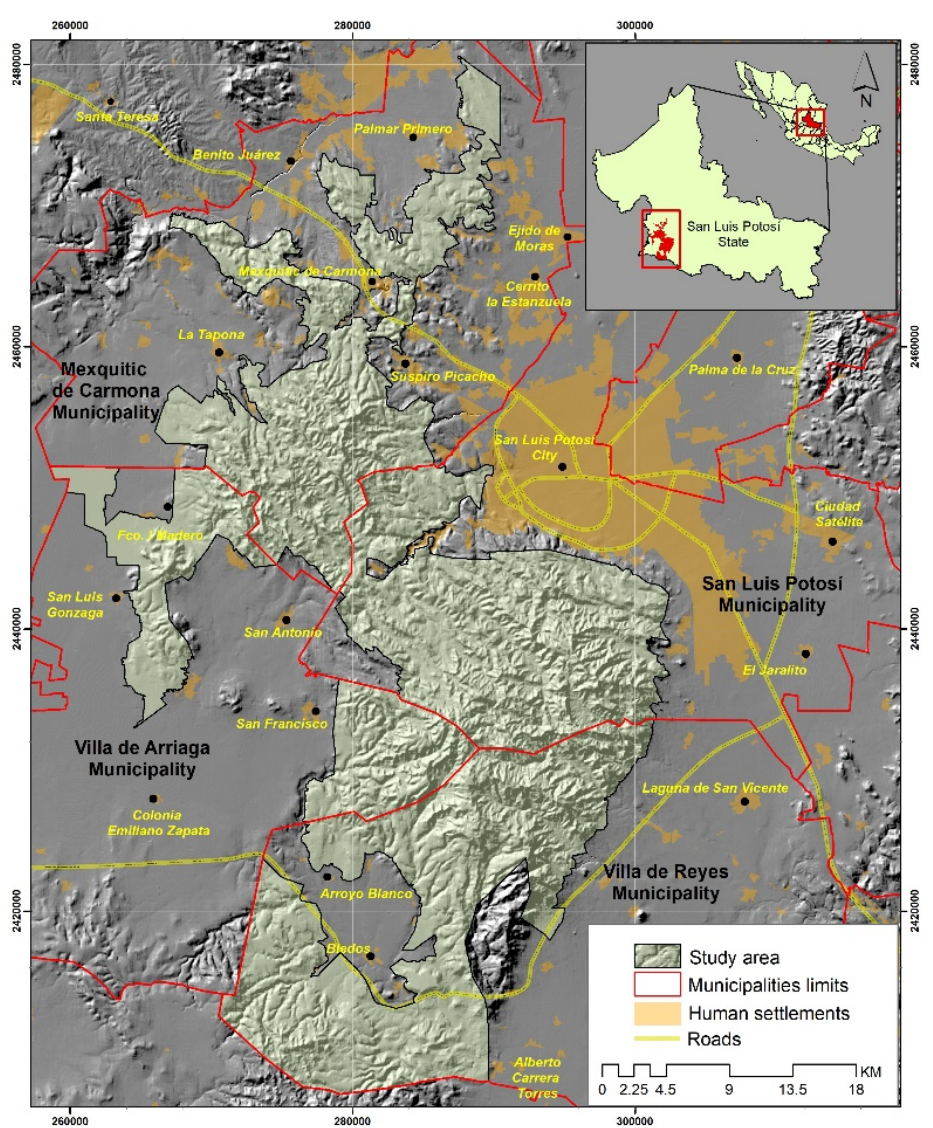
Figure 1. Location of the study area.